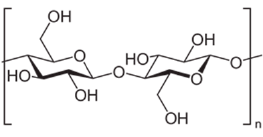
Figure 1. Cellobiose unit.